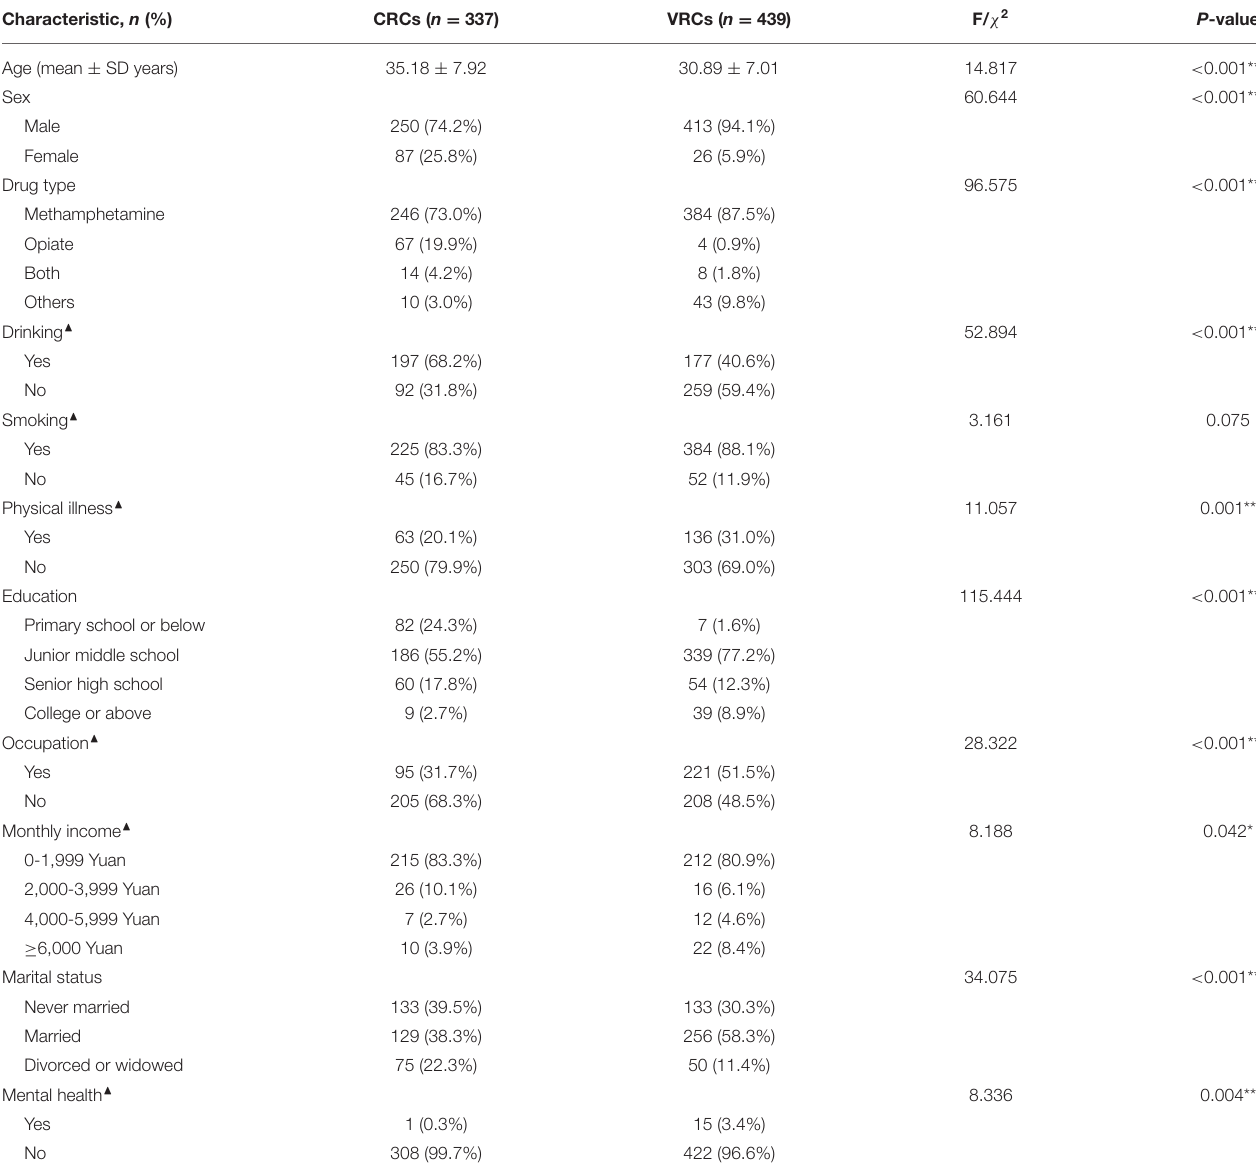
TABLE 1 | The characteristics and mental health of participants in CRCs and VRCs ( N = 776). Characteristic, n